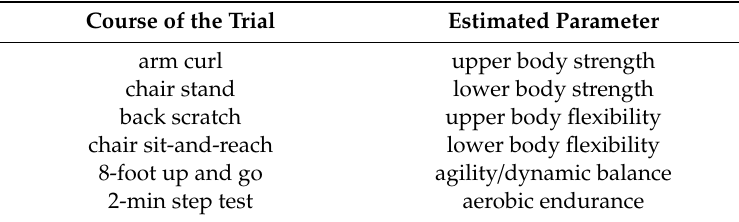
Table 1. Fullerton tests of the various parameters of elderly people’s